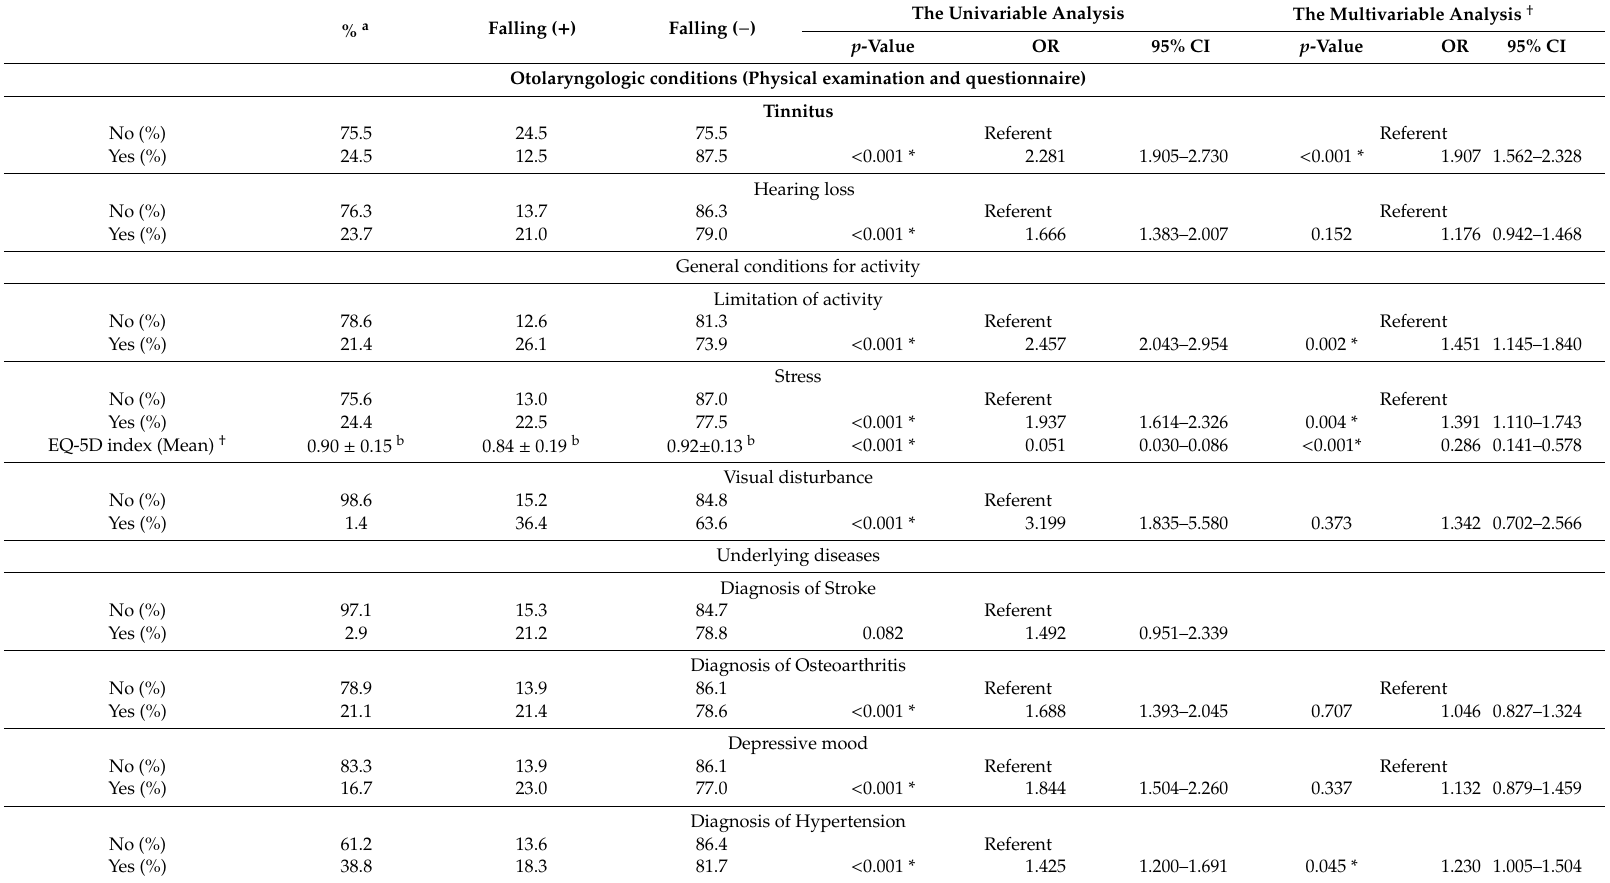
Table 3. Analysis of factors potentially associated with “Falling” in participants over 50 years